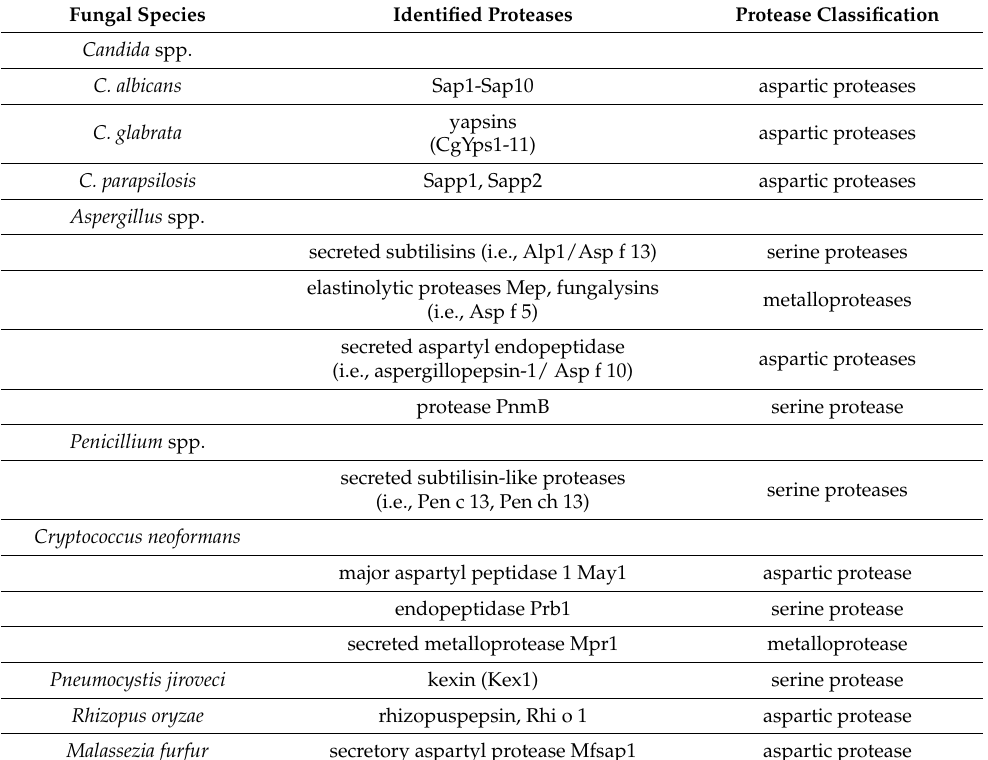
Table 1. Examples of extracellular proteases produced by selected fungi that are pathogenic for humans. Fungal Species Identified Proteases Protease Classification Candida